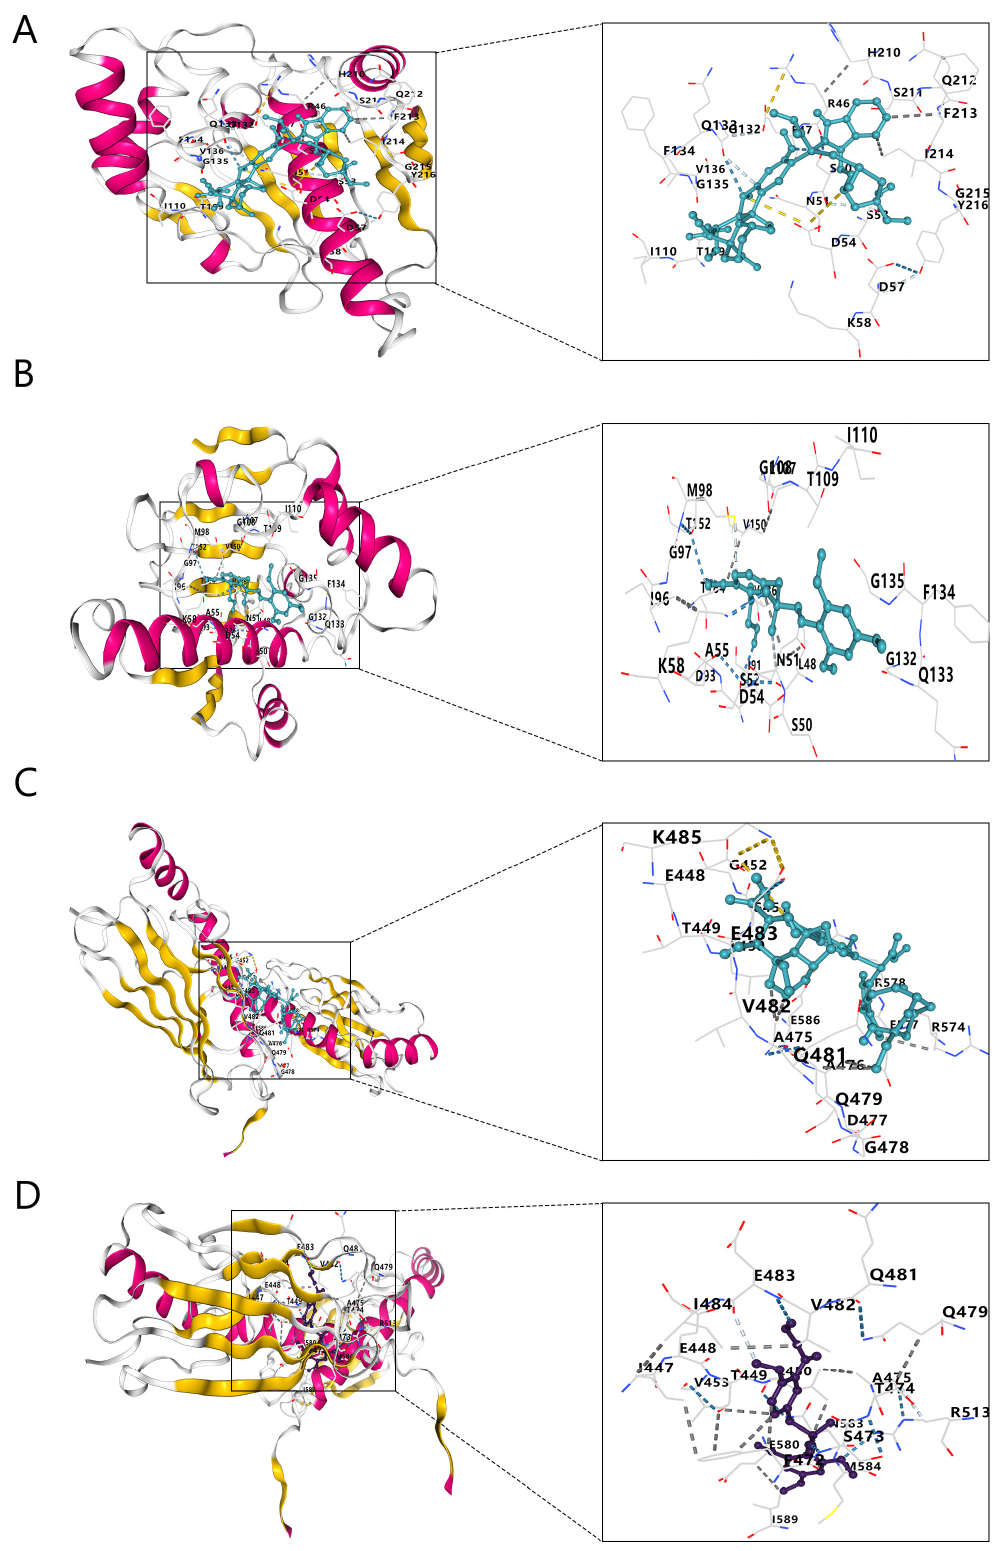
Figure 8. Molecular docking structures. ( A ) HSP90AA1 with vindesine. ( B ) HSP90AA1 with ON- 01910. ( C ) HSPA9 with vindesine. ( D ) HSPA9 with ON-01910.